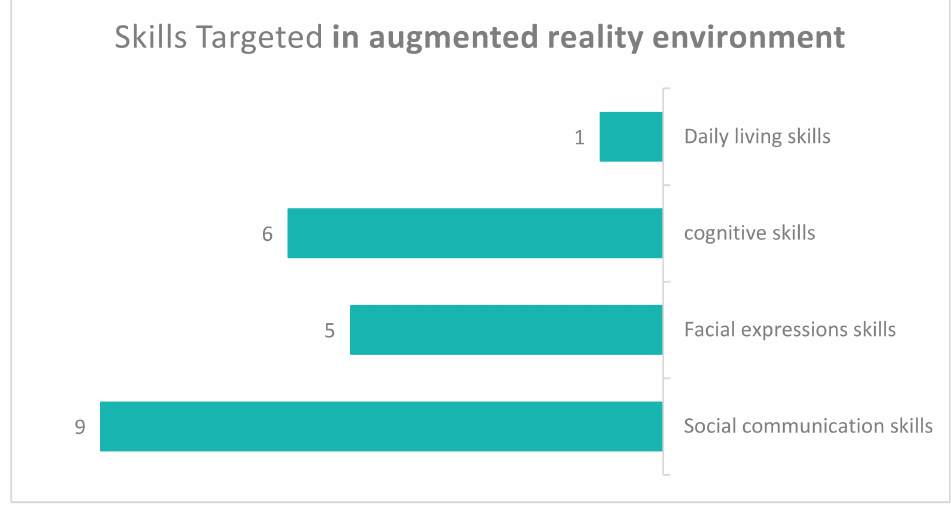
Figure 14. Skills Targeted in augmented reality